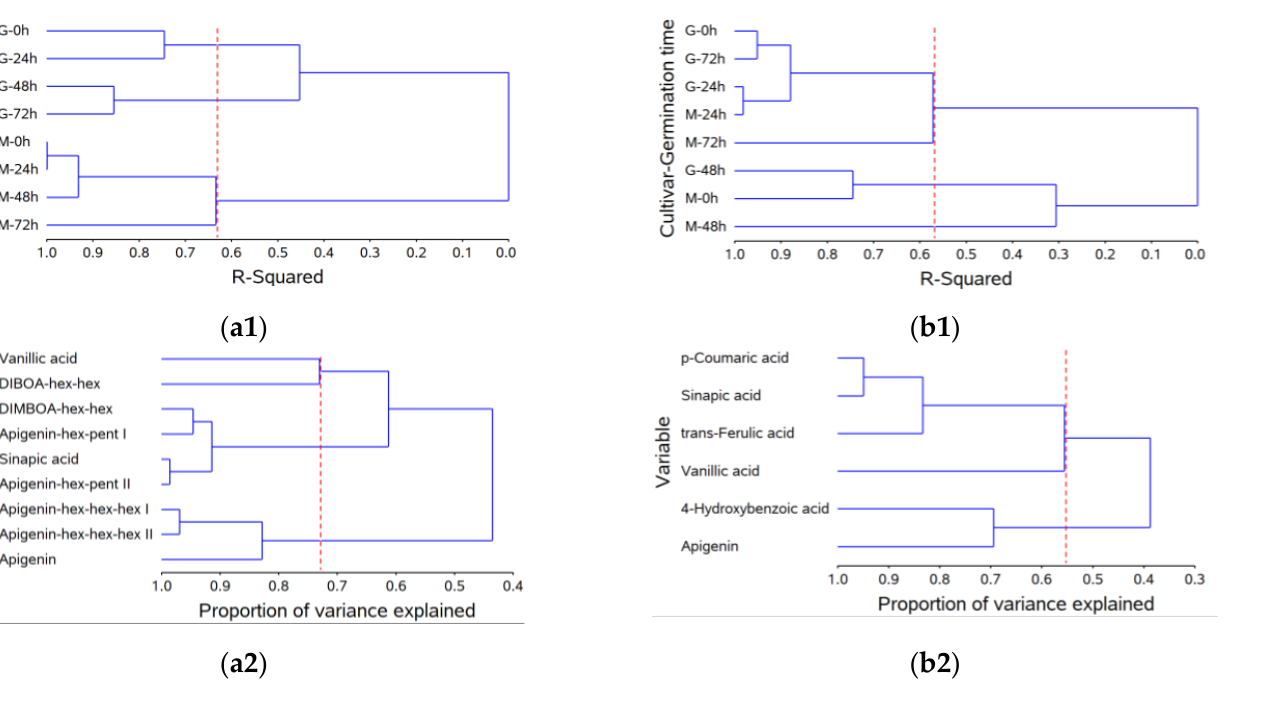
Figure 1. Dendrogram of wheat cultivars (G = Guaraim, M = Marcante) under different germination times (0, 24, 48 and 72 h; ordinate axis) in relation to the coefficient of determination (r2, abscissa axis) using Euclidean distance as a measure of dissimilarity and Ward ’ s agglomerative hierarchical algorithm as a clustering method for the free phytochemical fraction ( a1 ) and for the bound phyto- chemical fraction that was released after alkaline hydrolysis ( b1 ); and dendrogram of phytochemical content (mg/100 g, ordinate axis) in relation to the coefficient of determination (r2, abscissa axis) using the correlation matrix as a measure of similarity and the principal component as a clustering method for the free phytochemical fraction ( a2 ) and for the bound phytochemical fraction that was released after alkaline hydrolysis ( b2 ). a1 = 63.3% and a2 = 73.0%; b1 = 57.1% and b2 = 54.2%.